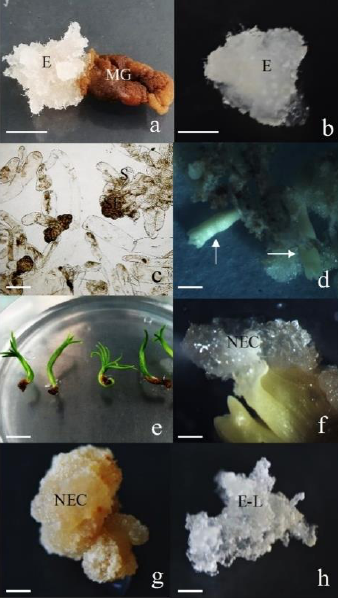
Figure 1. Characterization of Korean pine embryogenic callus, non-embryogenic callus and Figure1. CharacterizationofKoreanpineembryogeniccallus,